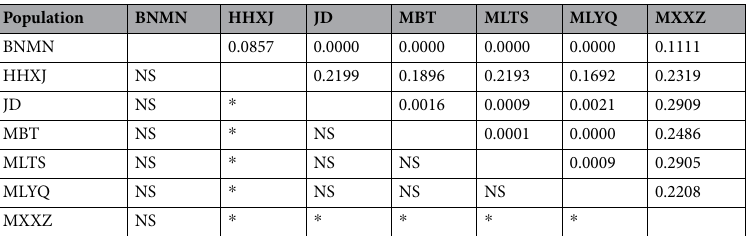
Table 3. Pairwise comparison of genetic distances ( F ST values) (above diagonal) and significance levels (below diagonal) values among seven populations with p = 6/r = 0.8. ( * Significance at the 5% nominal level; NS, not